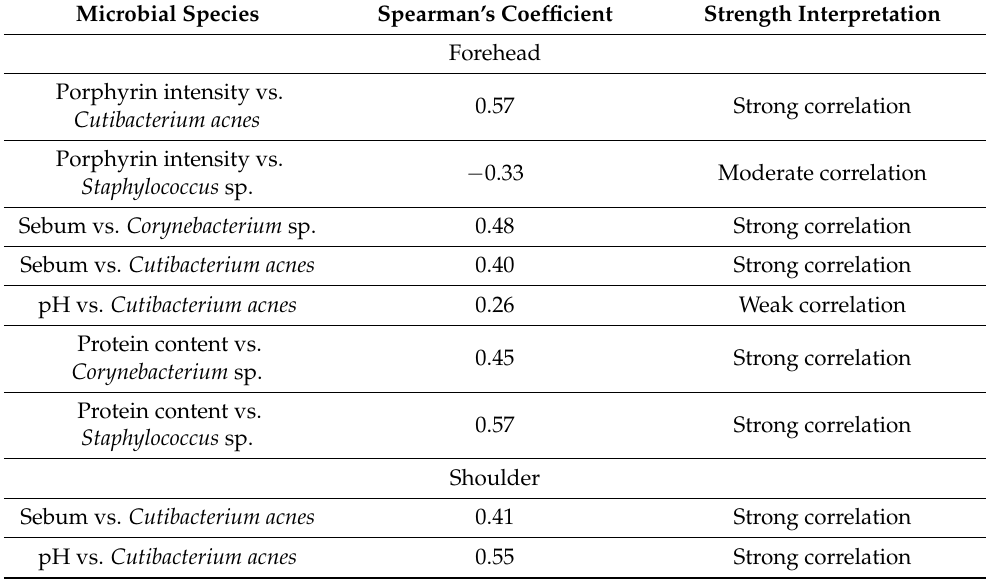
Table 7. Spearman’s correlation coefficients comparison and interpretation of the correlation between some biophysical parameter and bacterial species. The value ranges between +1 and − 1, where 1 is a total positive correlation and − 1 is a total negative correlation.